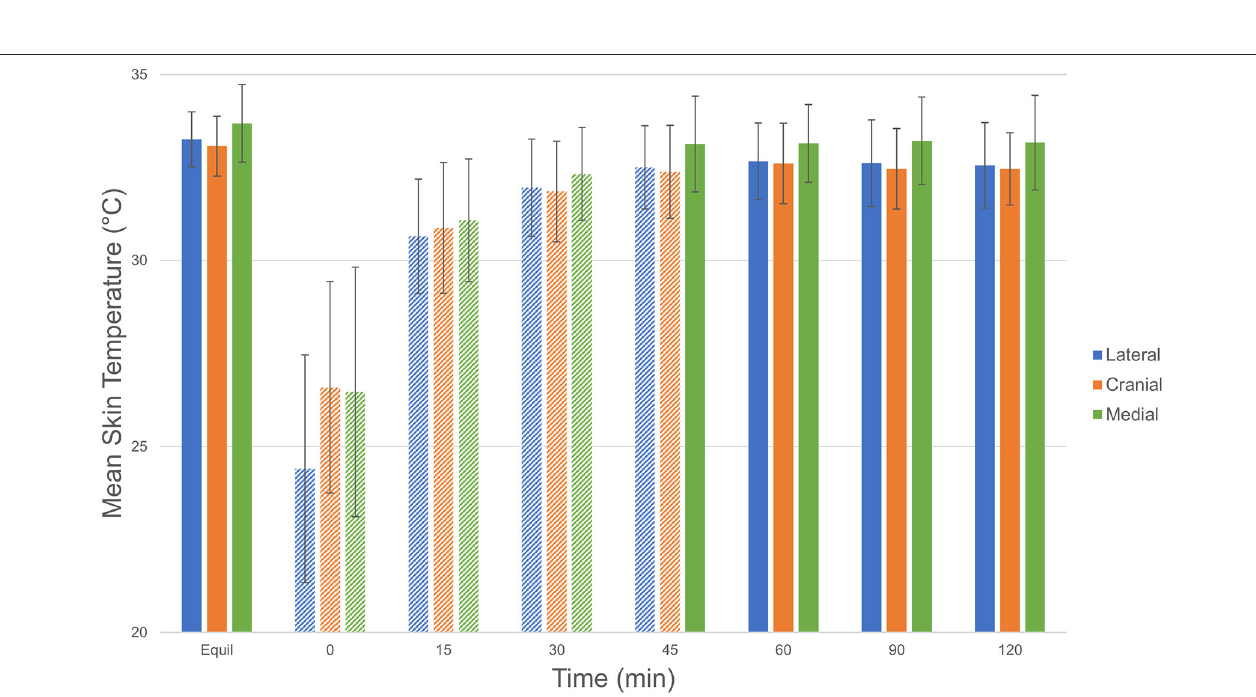
FIGURE 2 | Comparison of mean ± SD (standard deviation) skin temperature ( ◦ C) of each view (lateral [blue], cranial [red], and medial [green]) at equilibrium, 0, 15, 30, 45, 60, 90, and 120 min after cryotherapy. Bars with striped pattern indicate those with significant difference ( p < 0.001) from equilibrium. Comparison of mean ± SD (standard deviation) temperature ( ◦ C) of each view © 2021 by Sang Chul Woo is licensed under CC BY 4.0. To view a copy of this license, visit http:// creativecommons.org/licenses/by/4.0/.